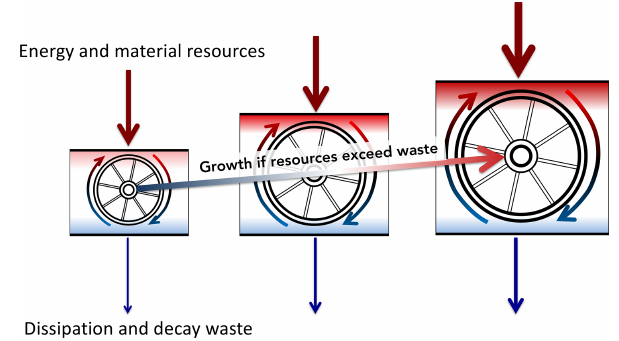
Figure 1. Representation of Lotka’s view on the thermodynamic mechanisms governing system growth, involving a wheel that en- larges and accelerates using an “un-utilized residue” of energy and matter representing the difference between consumed resources and